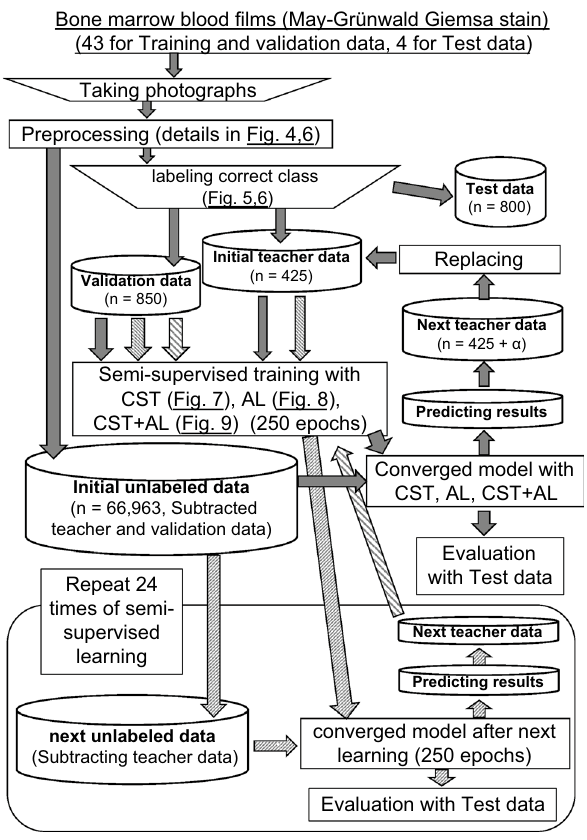
Figure 11. Overall flow of this study. The inverted trapezoidal frame shows manual processing or human judgment. The rectangular frame shows automatic processing by a hand-made program written in Python. The filled arrows indicate the flow in the first run of semi-authorized learning. Arrows with fine diagonal lines indicate the flow in the second run of semi-authorized learning. Arrows with rough diagonal lines indicate the flow in the third and subsequent runs of semi-authorized learning. CST: Confirmed self-training, AL: Active